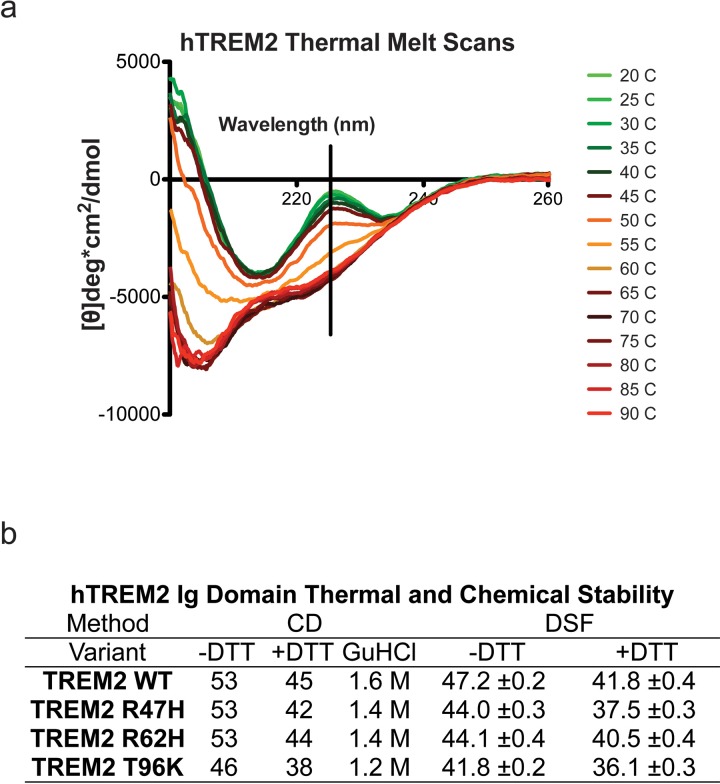
Structure and stability analysis by CD and DSF of human WT and AD-linked surface variant TREM2 ectodomains.(a) WT TREM2 melt curves measured in 5°C intervals. TREM2 shows a denaturation transition at 225 nm (black line). (b) Table of denaturation temperatures measured by CD or DSF and chemical denaturation concentrations of guanidine hydrochloride (GuHCl) measured by CD. CD denaturation experiments were performed on at least three independent protein preparations. DSF experiments were done in triplicate on at least two independent protein preparations. All error bars are SEM. Significance was determined by ANOVA with Bonferroni post-test correction. (***p<0.001).